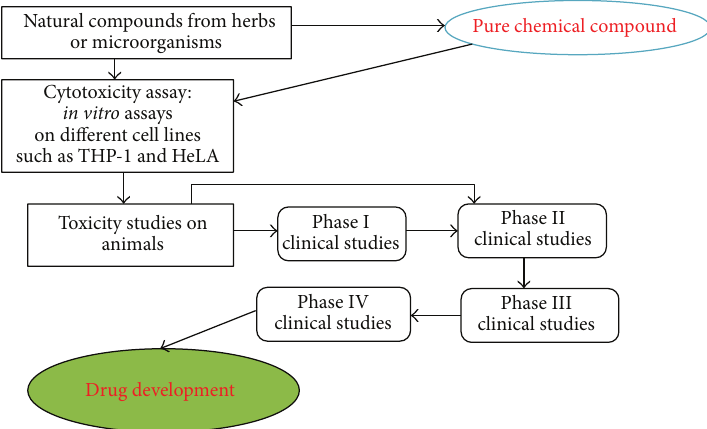
Figure 1: Herbal product as phytopharmaceutical: steps involved in the process of drug